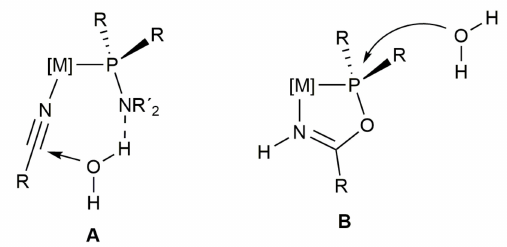
Figure 2. Structure of the intermediate species ( A , B ) commonly proposed in the catalytic hydration of nitriles with aminophosphine and phosphinous acid ligands,